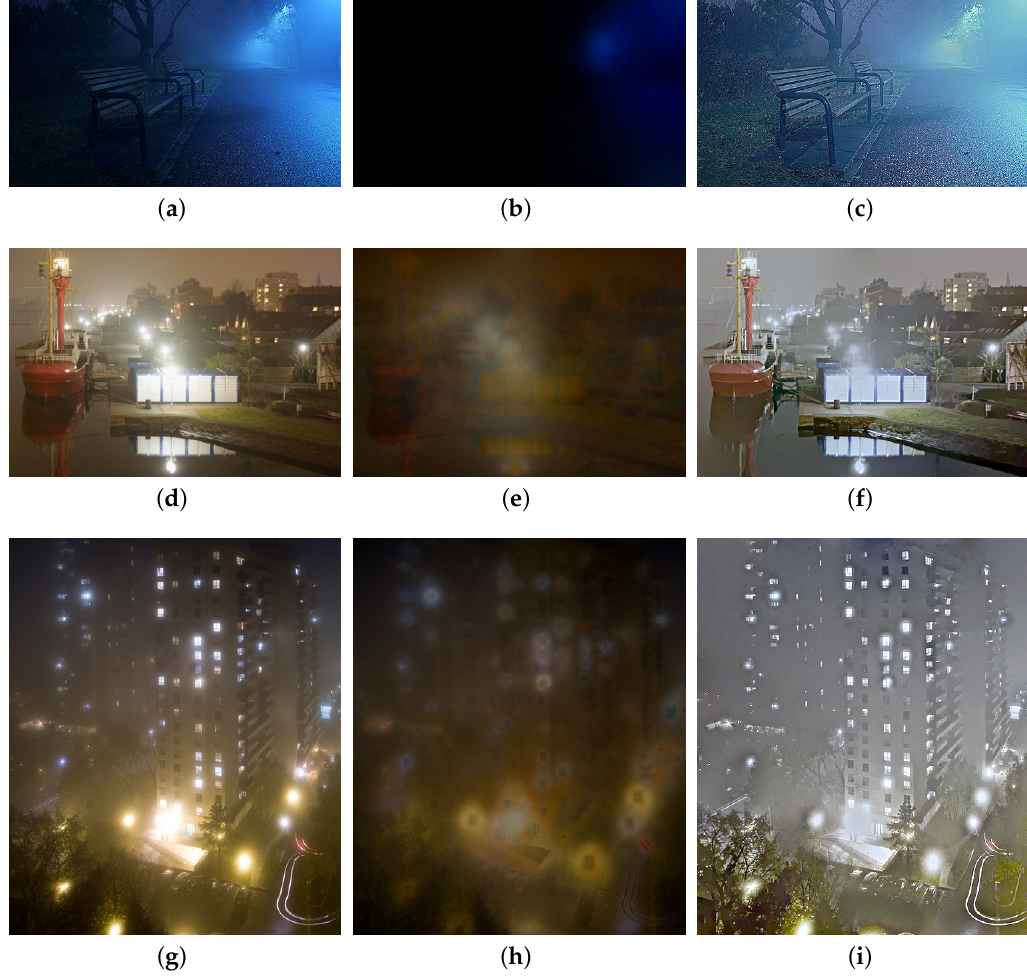
Figure 4. Illustration of halo layer extraction. ( a , d , g ): nighttime hazy images, ( b , e , h ): the halo layers, ( c , f , i ): the scene